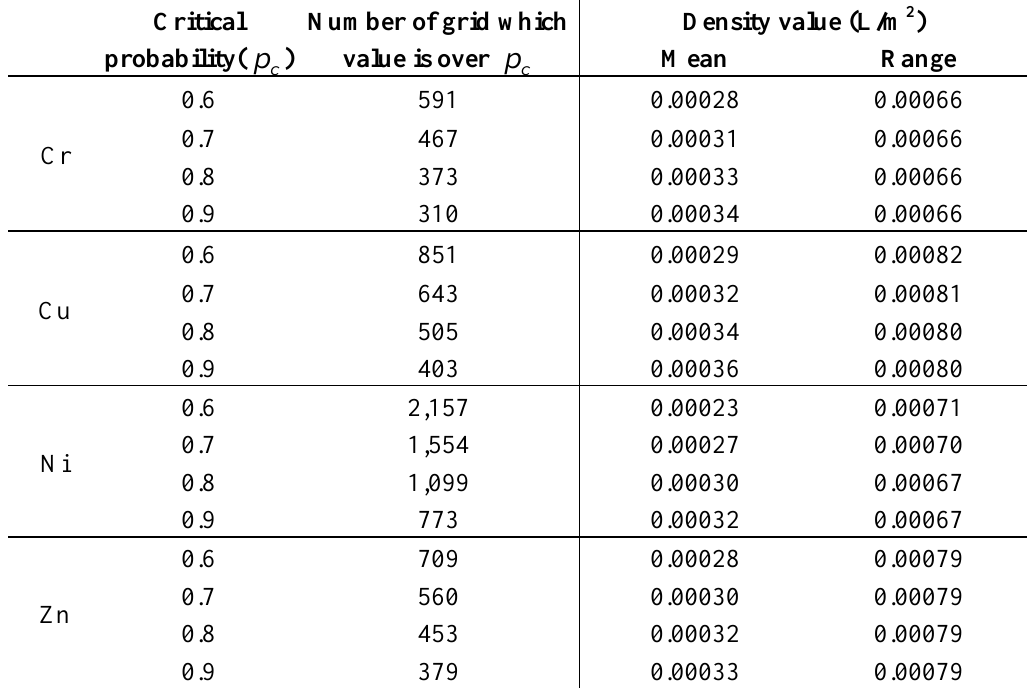
Table 4. Polluted sampling density value based on SIS probability